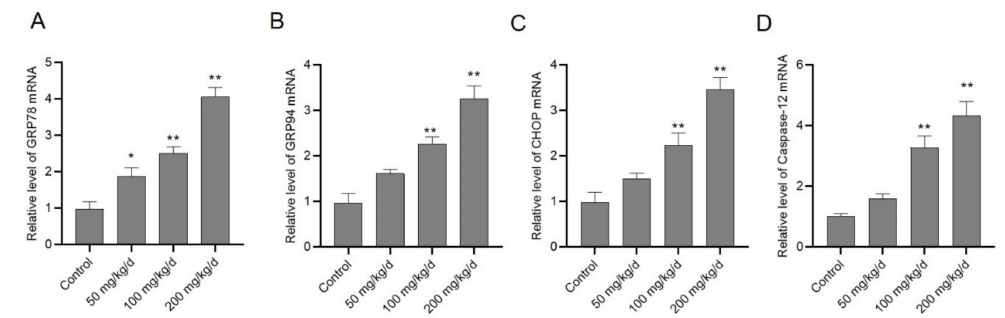
Figure 6. CuSO 4 exposure activates endoplasmic reticulum (ER) stress in the kidney tissues of mice. The mice were orally administrated with copper sulfate (CuSO 4 ) at the dose of 50, 100 and 200 mg / kg / day for 28 days, the mRNA expressions of GRP78 ( A ), GRP94 ( B ), CHOP ( C ) and caspase-12 ( D ) in the kidney tissues were determined. Data are presented as mean ± SD ( n = 7). * p < 0.05, or ** p < 0.01, compared to the control